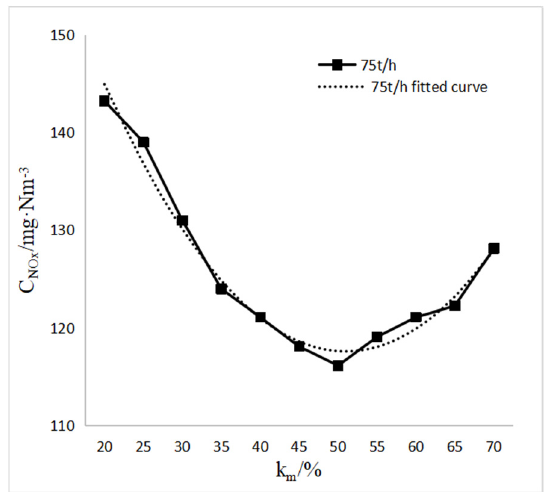
middle secondary air flow k upper secondary air flow + middle secondary air flow + lower secondary air flow